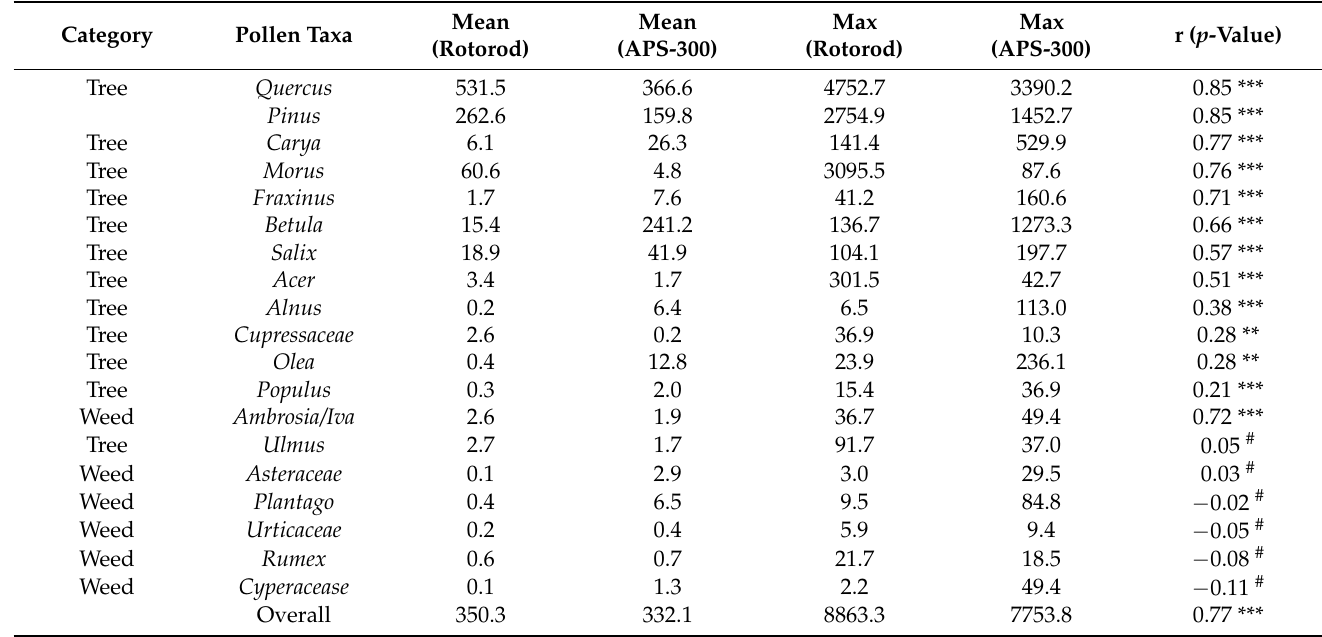
Table 1. Pearson Correlation of Matched Pollen Taxa Concentration measurements (Rotorod vs.